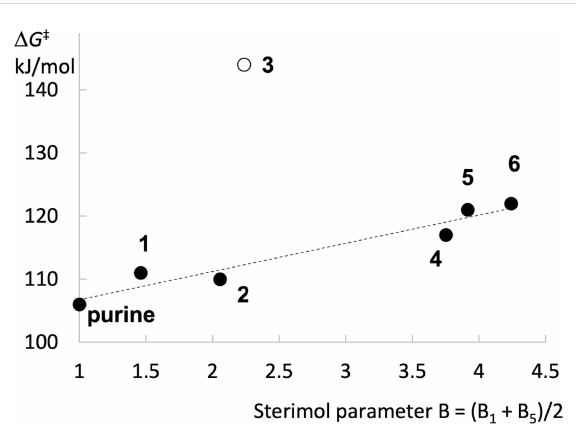
Figure 5: Relation between the Gibbs free energy barrier ( Δ G ‡ ) for the N 7-ferrocenoylation of C6-substituted adenines and the averaged per- pendicular Sterimol parameter B = (B 1 + B 5 )/2. The linear trendline is for illustration purposes only. Data point for 3 ( N 6 , N 6 -dimethyladenine; open circle) appears as an outlier. Purine (B = 1) is the anion derived from the parent 9 H -purine